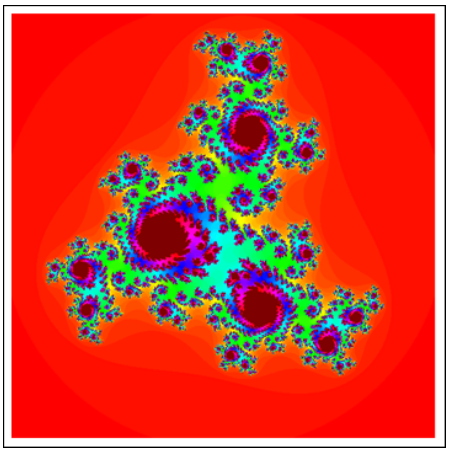
Figure 5. J-set of degree three via F-iterative process with image visual time = 75.12